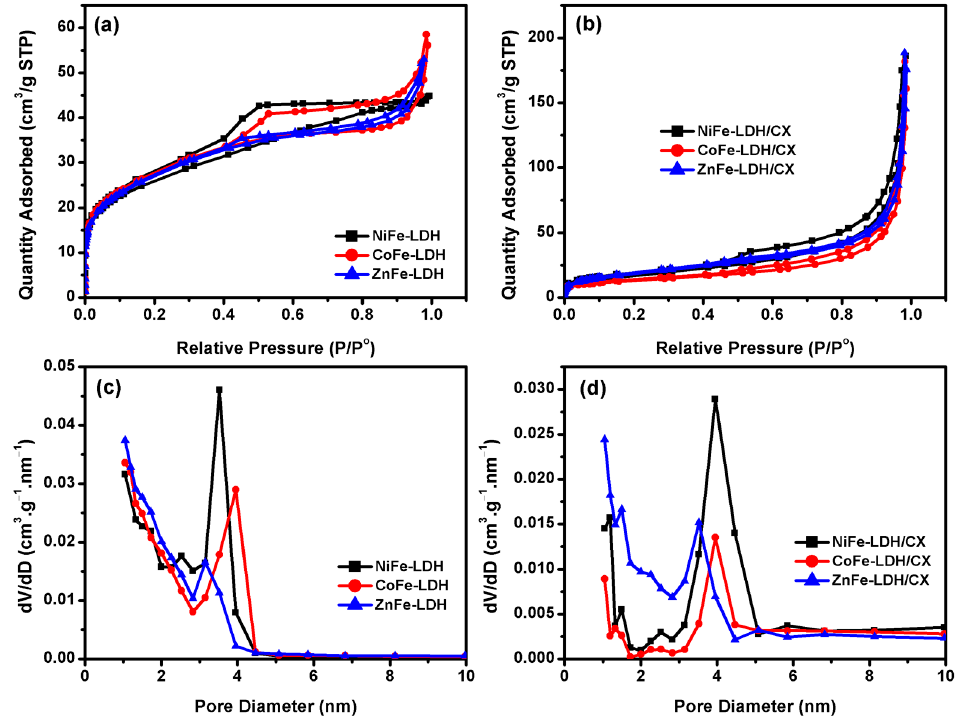
Figure 5. N 2 adsorption–desorption isotherms for ( a ) XFe-LDH, ( b ) XFe-LDH/CX, ( c ) and ( d ) BJH pore size distribution plots of the as-prepared materials.